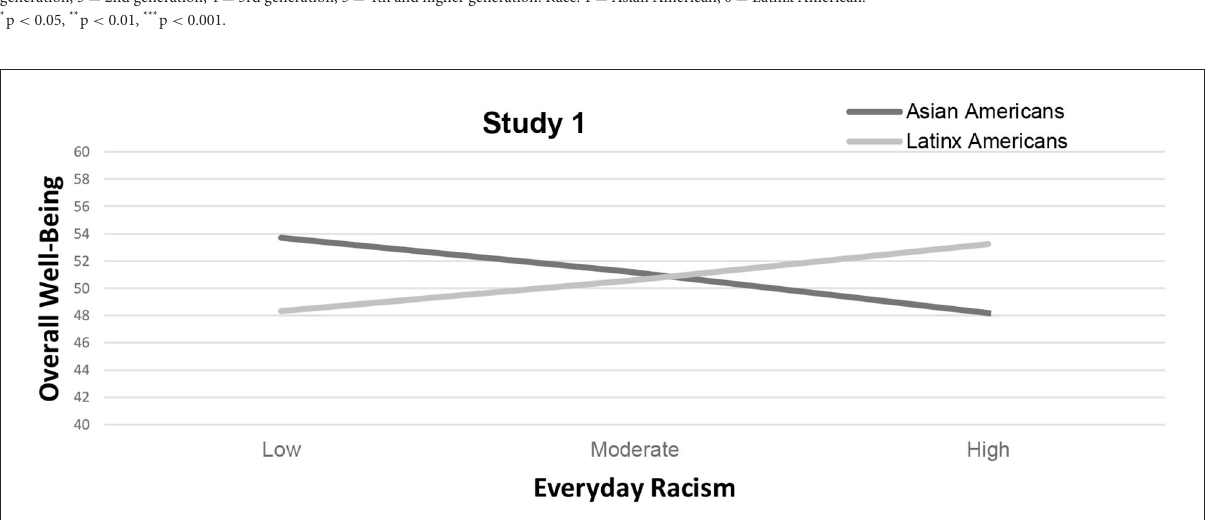
FIGURE2 Changes in overall well-being as a function of race and everyday racism for study 1. Note . Results suggest race as a significant moderator ( p < 0.05) for the relationship between everyday racism and overall well-being. Asian Americans experience lower overall well-being as a function of experiencing everyday racism compared to Latinx